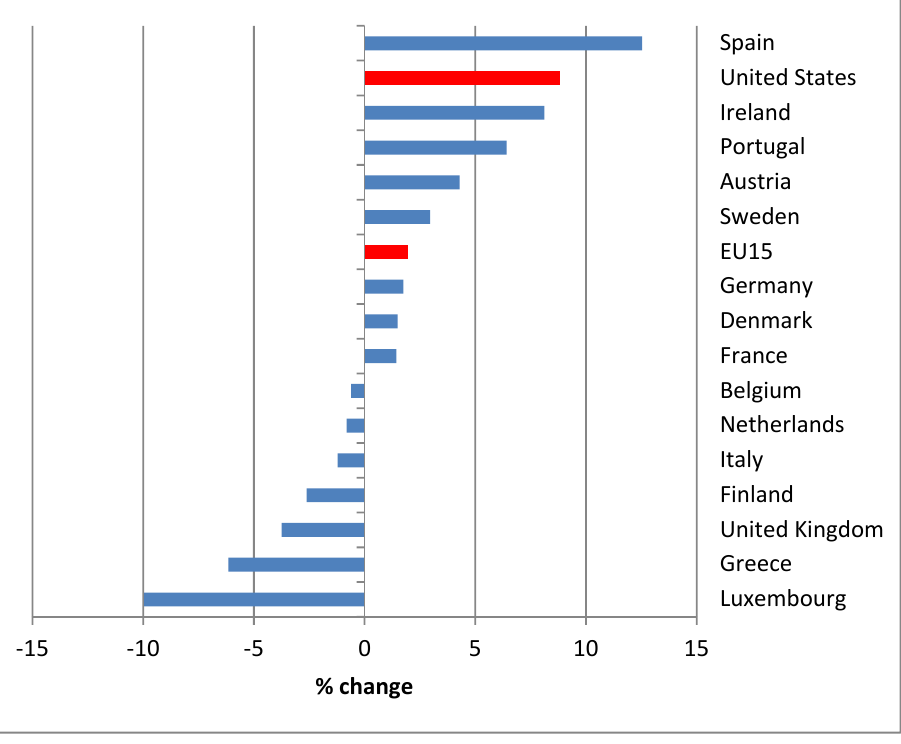
Source: own ellaboration from OECD